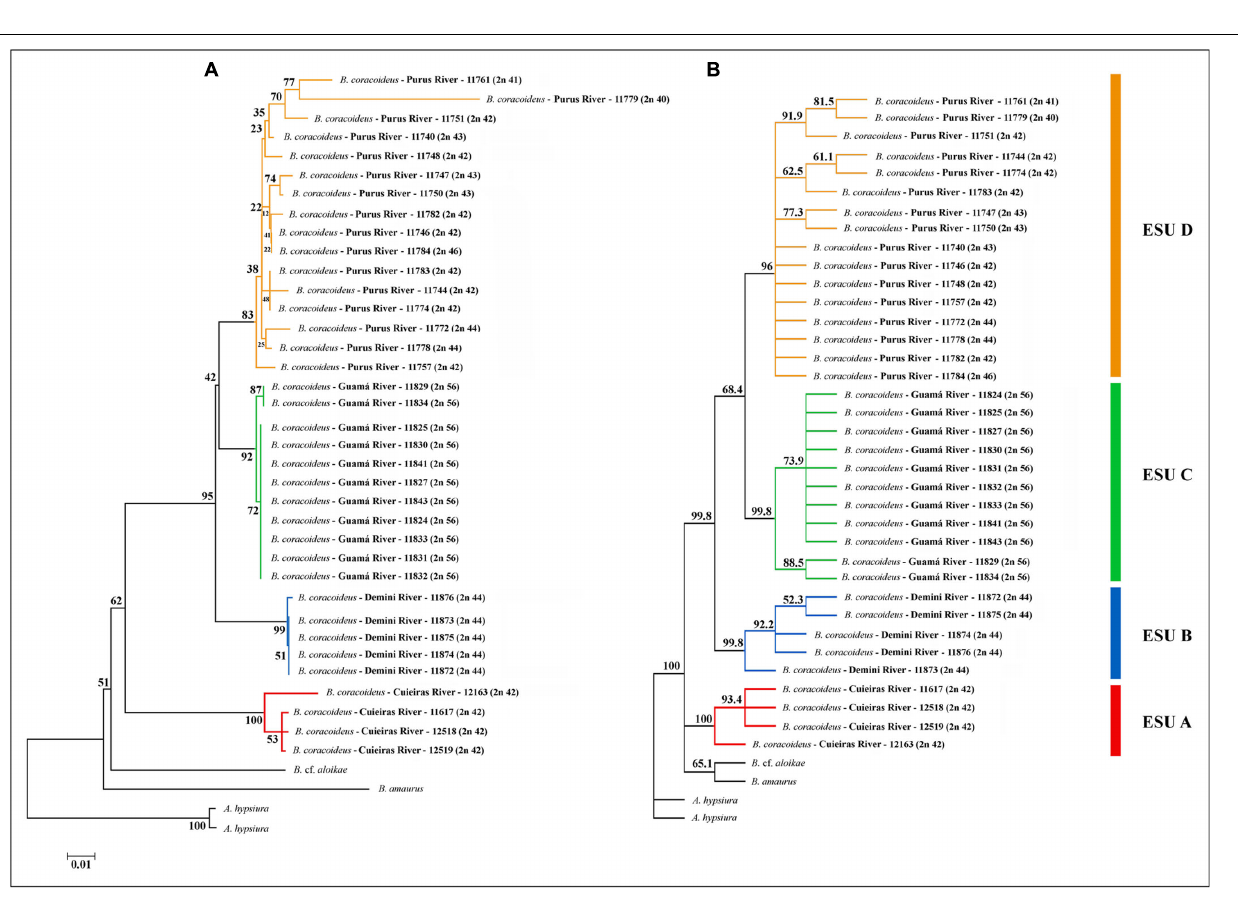
Frontiers in Genetics |